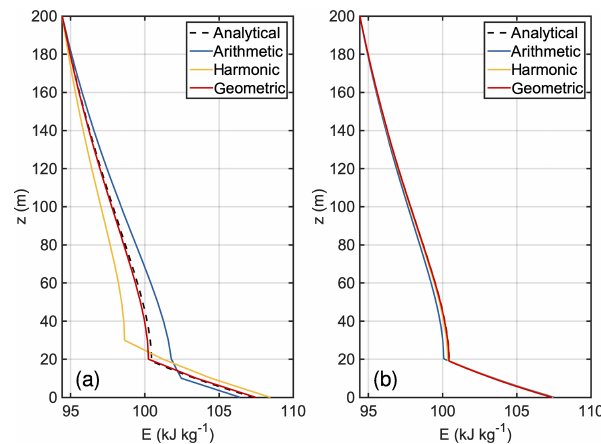
Figure 2. Simulated steady-state profiles of the enthalpy E com- puted with the three conductivity models with K 0 /K c = 10 − 5 and a vertical resolution of (cid:49)z = 10m (a) and (cid:49)z = 0 . 5m (b) compared to the analytical profile.